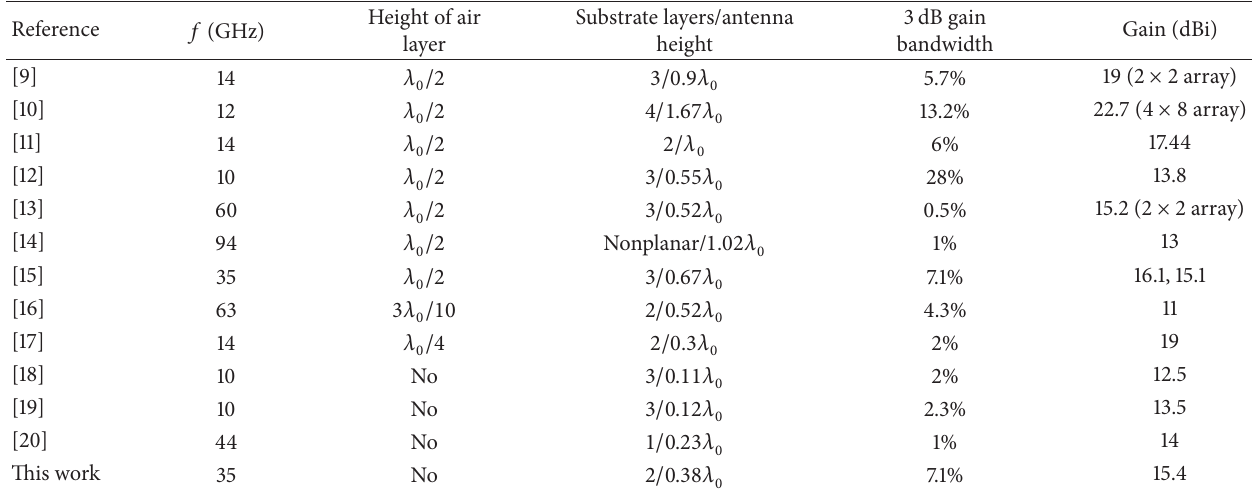
Table 1: Performances of the published F-P